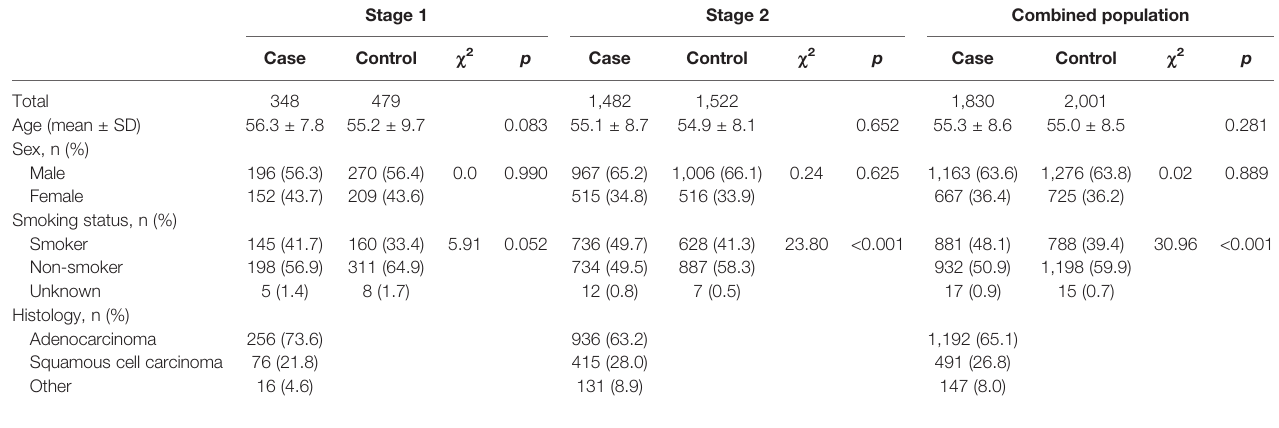
TABLE 1 | Characteristics of subjects in the two-stage case – control